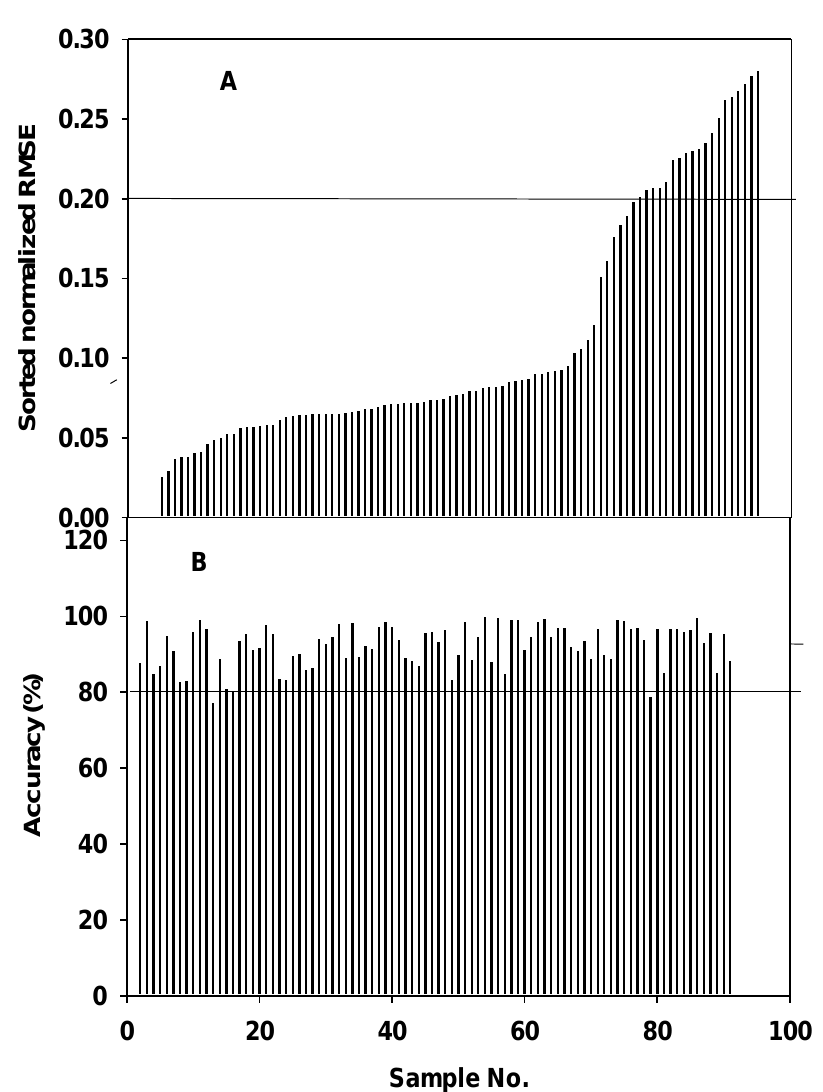
Figure 4 Statistical comparison between standard laboratories tests and photographic measurements of %N. ( A ) Normalized root mean square error (RMSE) of %N. Equation (2) The horizontal solid line is a separator between errors above and below 0.2 ( B ). Percent accuracy of N% Equation (4). The horizontal solid line is a separator between smartphone accuracy of N% above and below 80% agreements with laboratory reference.